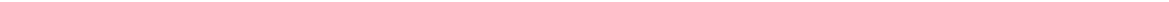
Fig. 7 Functional regulation of Npm by intramolecular interactions. a Npm domain map and truncations used in these experiments. Truncation names and residue numbers shown on right. b Equilibrium tryptophan fl uorescence binding curves derived from the Npm tail and truncations binding to either H2A/H2B or H3/H4. Points represent average values of three replicates for each binding curve. Standard error of the points is included during the calculation of the binding curves and dissociation constants. c Dissociation constants ( K D ) and standard errors ( ± ) of Npm tail and truncations derived from b . d Competitive pull-down assays using various truncations of the Npm tail and StrepII-tagged H2A/H2B dimers. Lanes 1 – 4, 10% inputs. Lanes 5 – 8, resin only controls. Lanes 9 – 12, standard pull-down assays. Lanes 13 – 18, competitive pull-down assays. Presence of Npm truncation bands in competitive pull-down lanes indicate higher af fi nity for H2A/H2B. e Chromatin assembly assay comparing the full-length Npm (residues 1 – 195) and tail